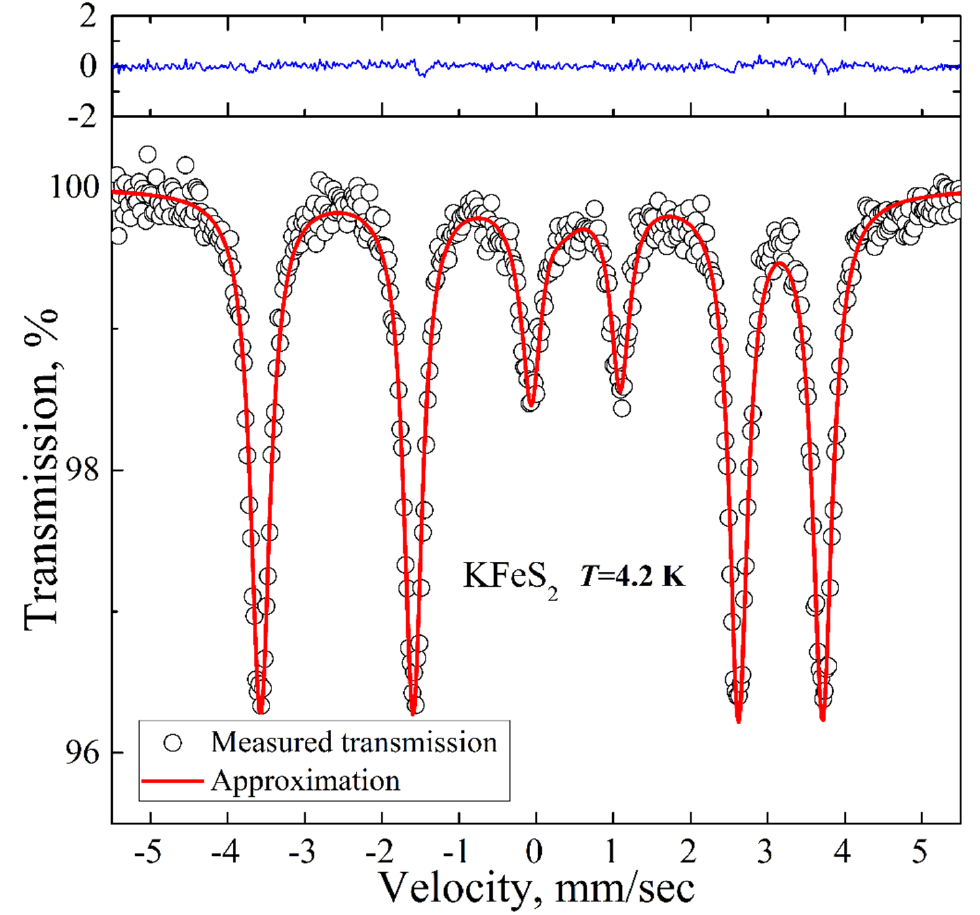
Figure 4. Low-temperature 57 Fe Mössbauer spectrum of KFeS 2 (empty circles). Solid red lines represent the best fitting of the spectrum obtained by the least-squares fit (red line) under the assumption that the line shapes are Lorentzian. The blue line represents the difference between the measured spectrum and the fit.